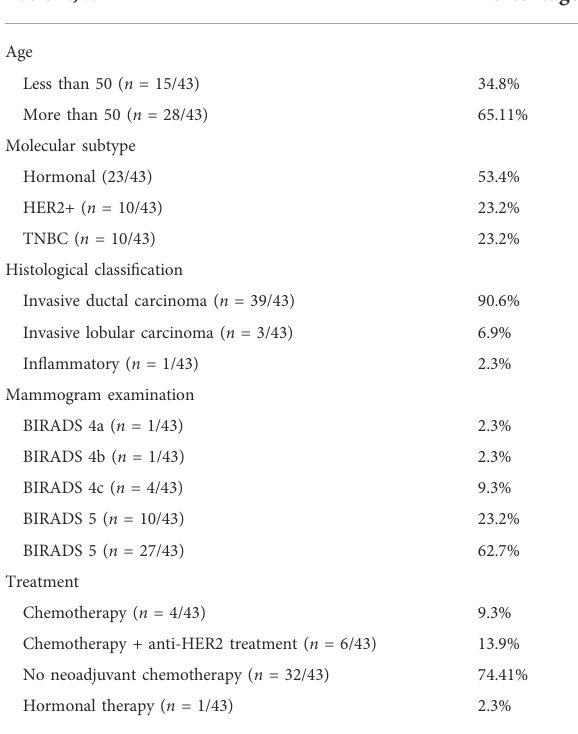
TABLE 1 Clinical features of collected BC